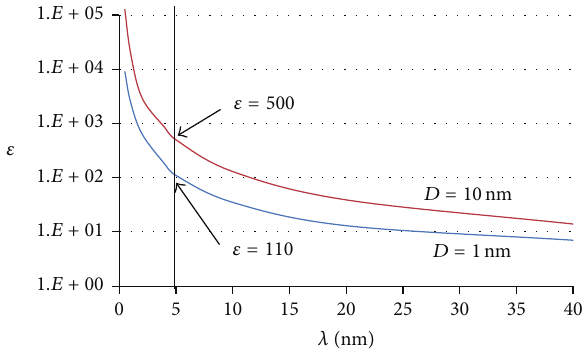
Figure4:Relationbetweenthedielectricconstantofnonconductive thin films and the screening length of thin films with 𝜀 = 5 , and = 5 , and 𝑉 = 1 𝑅 = 20 nm, ℎ = 1 nm, 𝜀 2 0